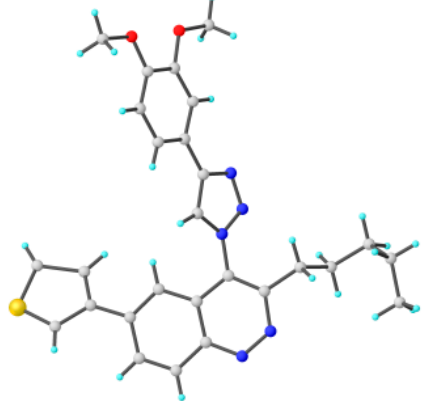
Figure 6. Molecular structures of triazolylcinnoline 11g obtained from X-Ray analysis.